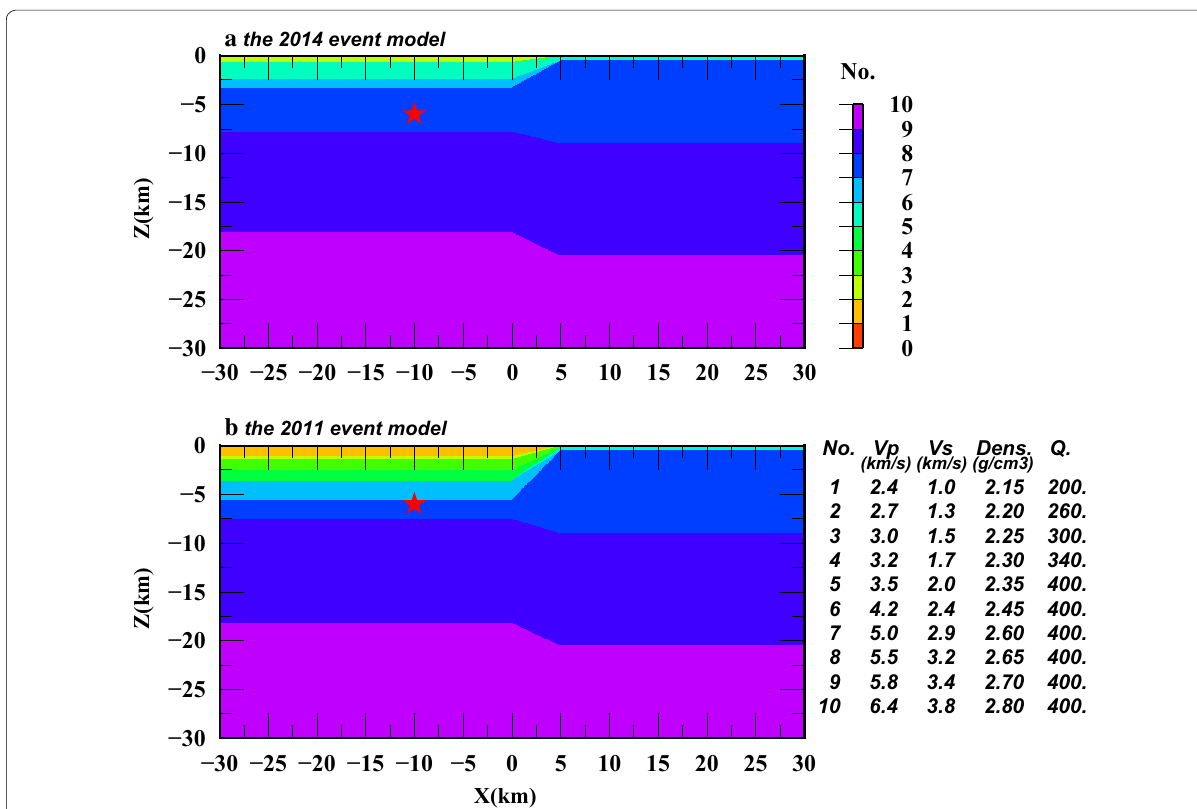
Fig. 9 2-D velocity structure models using a comparison of wave propagation characteristics. Lower and upper models correspond to the source regions for the 2014 and 2011 events, respectively. Red stars indicate the source points. Color contours show the layer numbers. The table at the lower right provides the layer